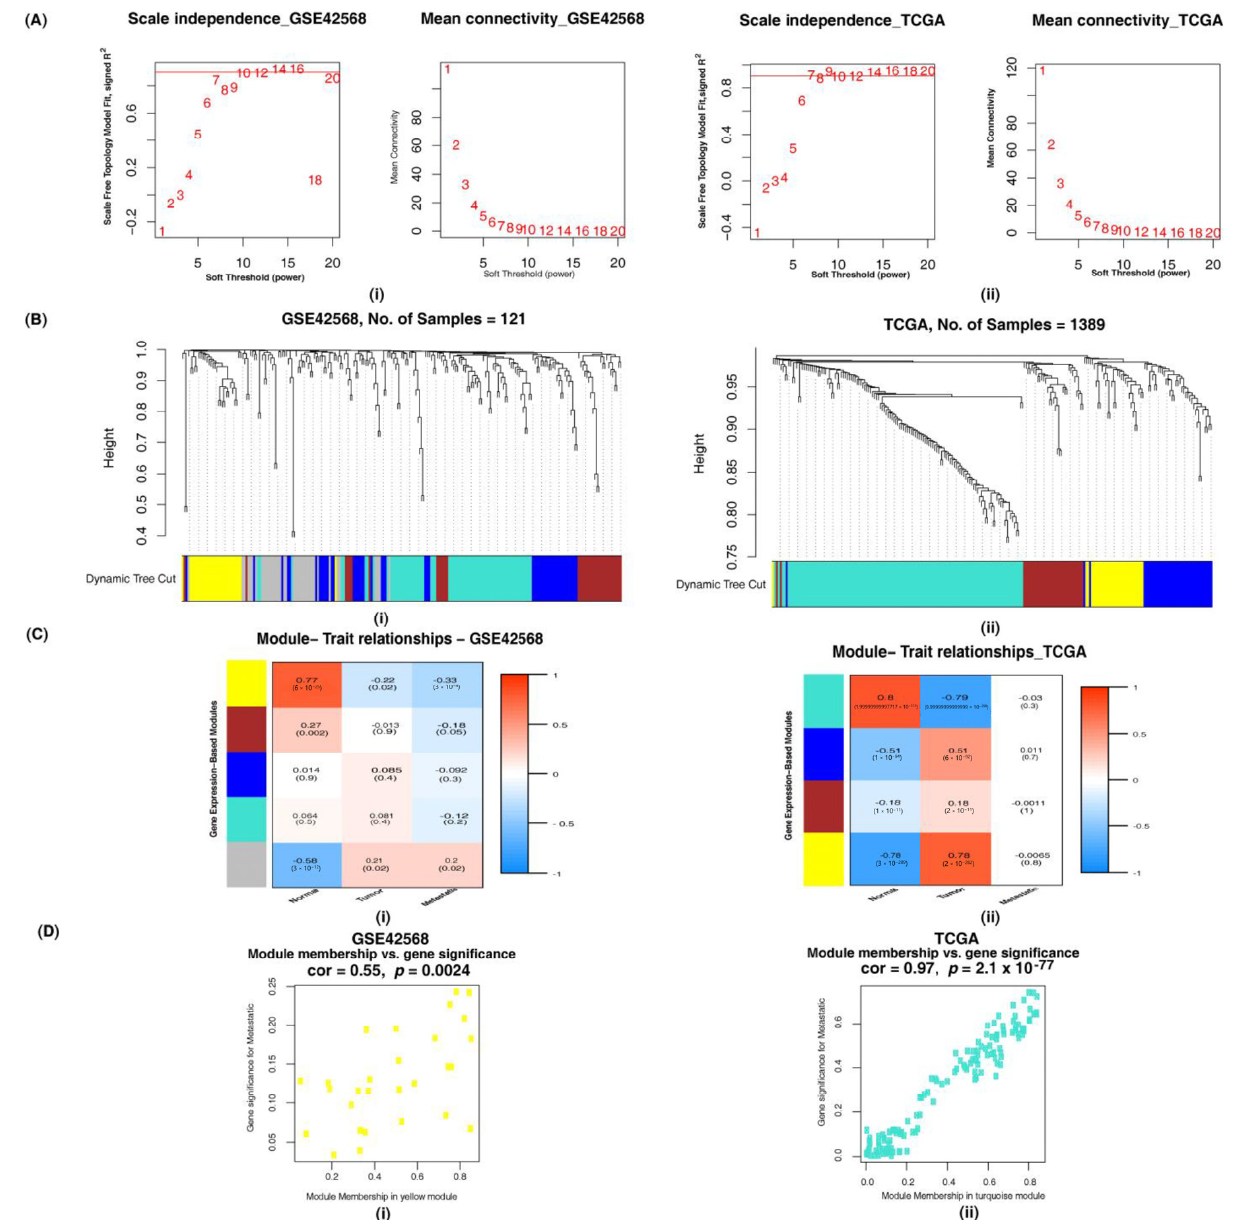
Figure 3. Co-expressed ion channel modules based on the non-redundant HT DEGs. ( A ) Soft- thresholding power to ensure scale-free network model: ( i ) A soft-thresholding power of 10 was chosen in the microarray dataset (GSE42568) corresponding to non-redundant HT DEGs; ( ii ) A soft-thresholding power of 7 was chosen in the RNA-Seq dataset corresponding to non-redundant HT DEGs ( B ) Hierarchical clustering of genes into modules. Modules are assigned different colors as depicted in the horizontal bar below the tree diagram: ( i ) 4 modules (yellow, blue, turquoise and brown) were obtained in the microarray dataset (GSE42568); ( ii ) 4 modules (turquoise, brown, yellow and blue) were obtained in RNA-Seq. ( C ) Correlation between module eigengenes and binary traits—normal, tumor and metastatic. Rows correspond to modules depicted as different colors and columns are the binary traits. Numbers in each cell are the correlation coefficient between module eigengenes and the binary traits and the corresponding p -value. ( i ) The yellow module was chosen as a significant module from the microarray dataset (GSE42568). ( ii ) The turquoise module was chosen as a significant module from RNA-Seq. ( D ) Scatter plot of gene significance (GS) for the binary trait vs. the module membership (MM) in the selected module. ( i ) GS-MM plot of the yellow module in the microarray (GSE42568) dataset. ( ii ) GS-MM plot of the turquoise module in the RNA-Seq